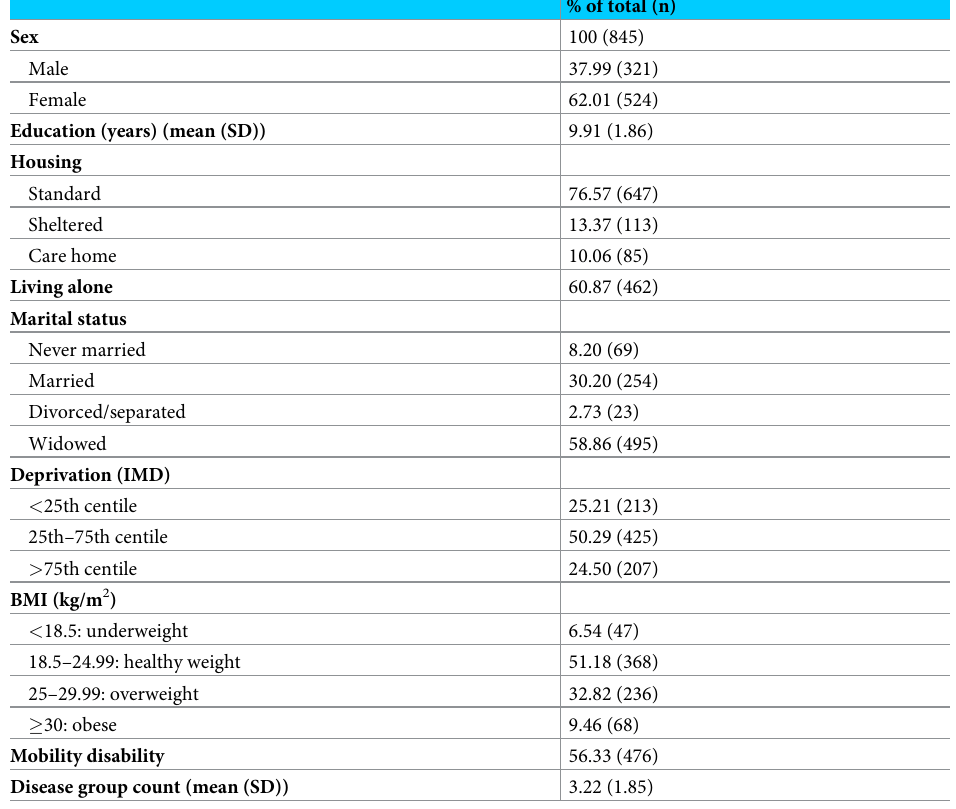
Table 1. Baseline sociodemographic and health characteristics of Newcastle 85+